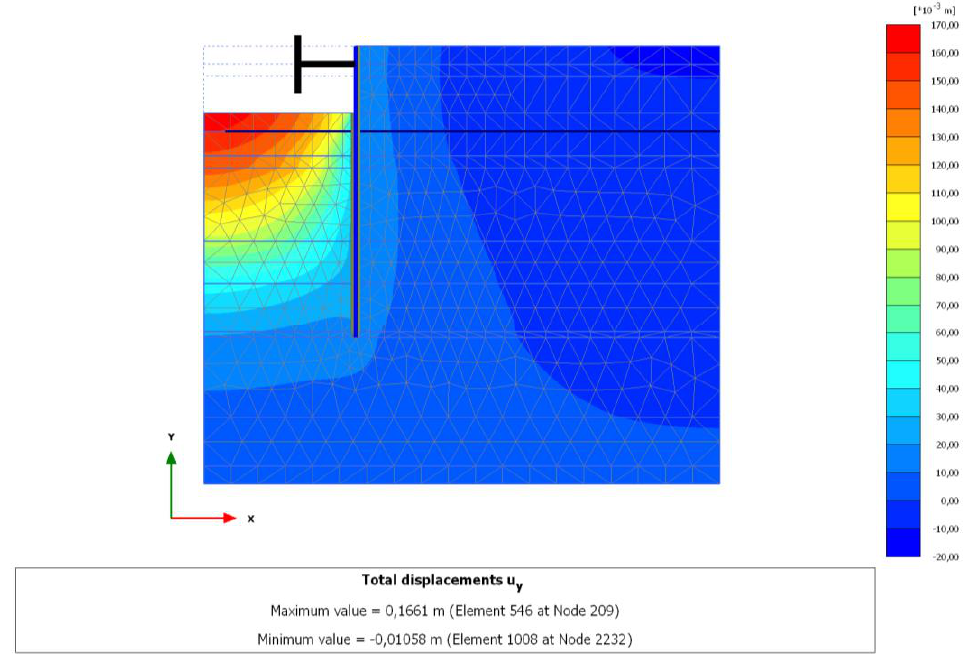
Figure 7. Displacement profile along Y axis